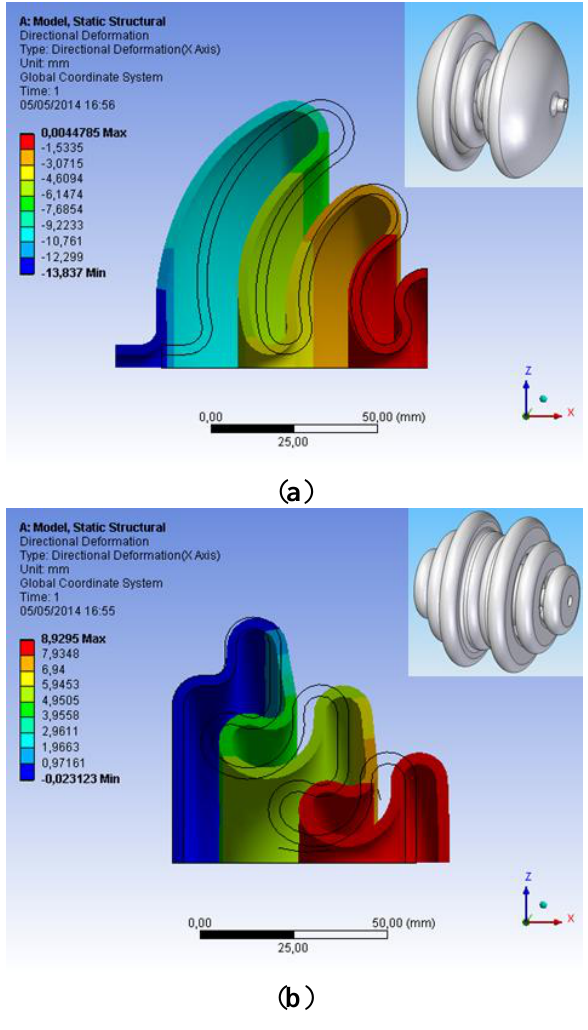
Figure 1. ( a – c ) Example of AM actuators with linear expansion motion with the analysis of an eighth of the part. ( d ) AM actuator with quasi linear expansion motion with the analysis of half